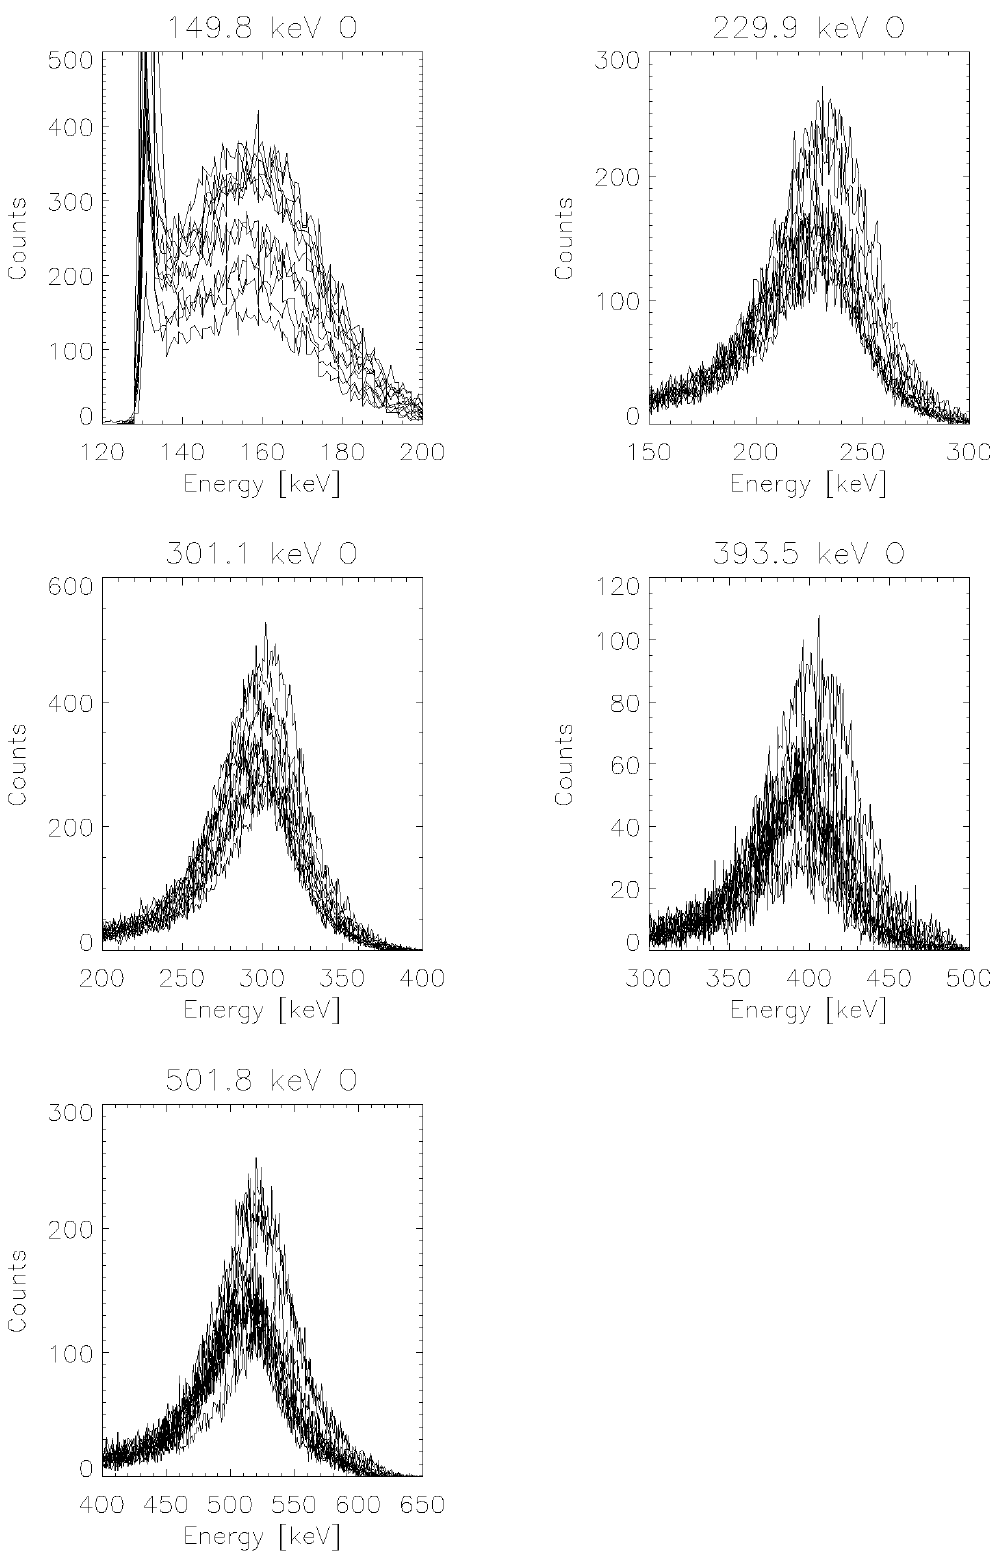
Fig. 8. Responses of all the detectors to oxygen neutral atom beams of different energies (149.8, 229.9, 301.1, 393.5 and 501.8keV,